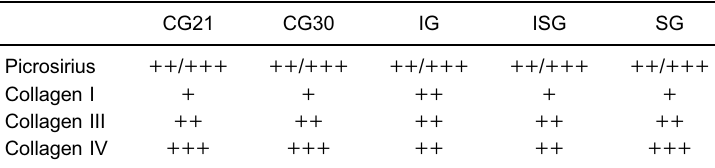
collagen types I, III, and IV. CG21: 21-day control group; CG30: 30-day control group; IG: immobilized group; ISG: immobilized and stretched group; SG: stretched group. Protocol described by Kurose et al. (19): ( – ) absent; ( ± ) weakly positive; ( + ) slightly positive; ( ++ ) moderately positive; ( +++ ) strongly